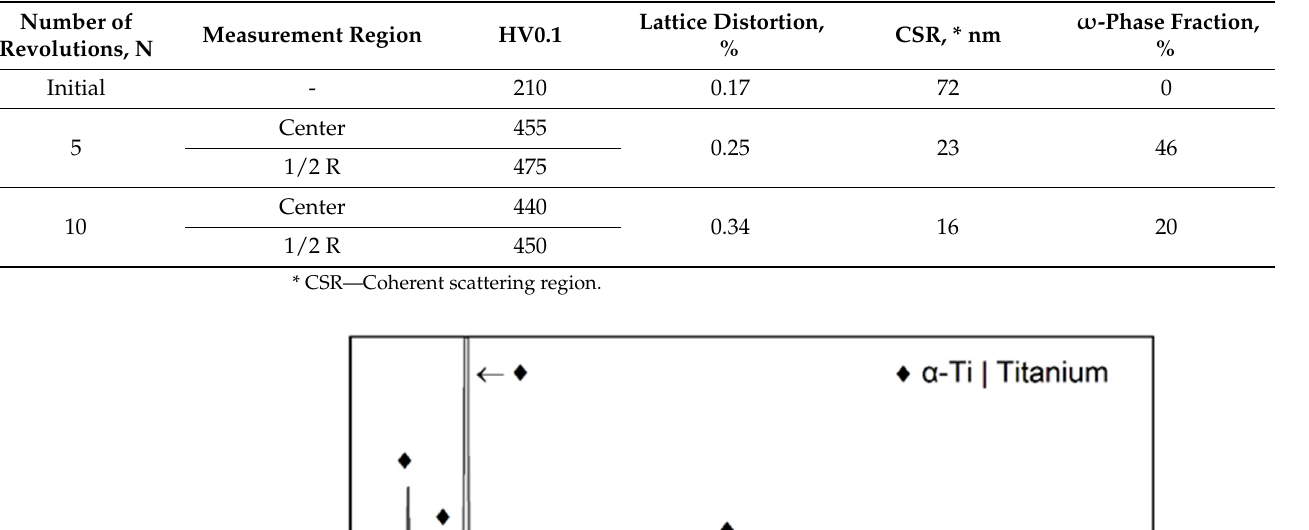
Table 2. Results of HV measurements and the XRD analysis of Ti before and after HPT.